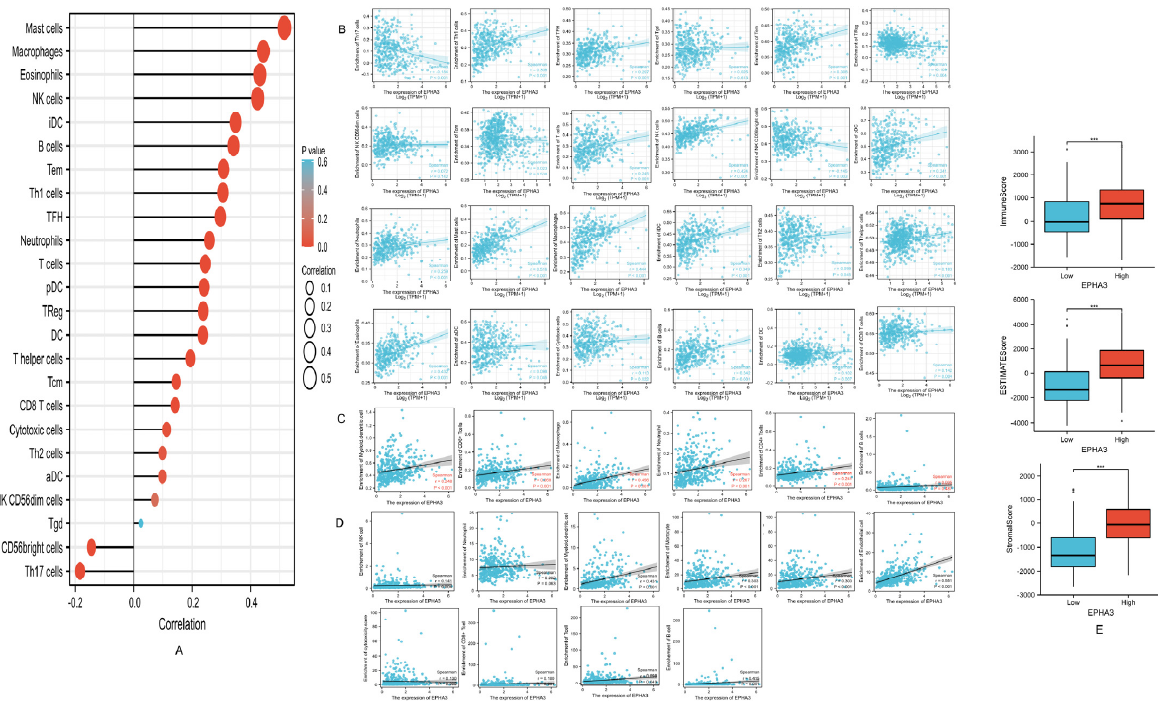
Figure 13. (A ) Association of EPHA3 level with immune cell infiltration levels in TCGA-BLCA. ( B ) The correlation of EPHA3 level with 24 common immune-infiltrating cells was evaluated by ssGSEA. ( C ) Scatter plots indicating EPHA3 level with 24 common immune cell infiltration levels based on the TIMER method. ( D ) Scatter plots indicating EPHA3 levels with 10 common immune cell infiltration levels using MCP-counter algorithm. ( E ) The stromal, immune, and ESTIMATE scores between the high and low EPHA3 expression groups were explored using the ESTIMATE algorithm. *** p <